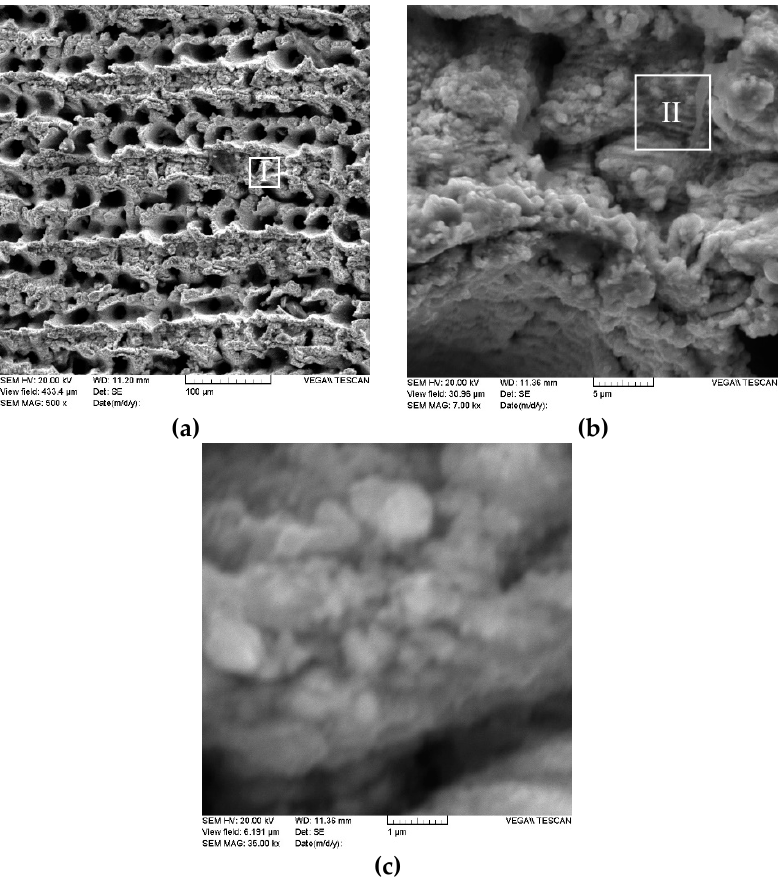
Figure 5. SEM images: ( a ) periodic cone-shaped microstructures on the sample surface; ( b ) enlargement of the marked area I; ( c ) enlargement of the marked area II.